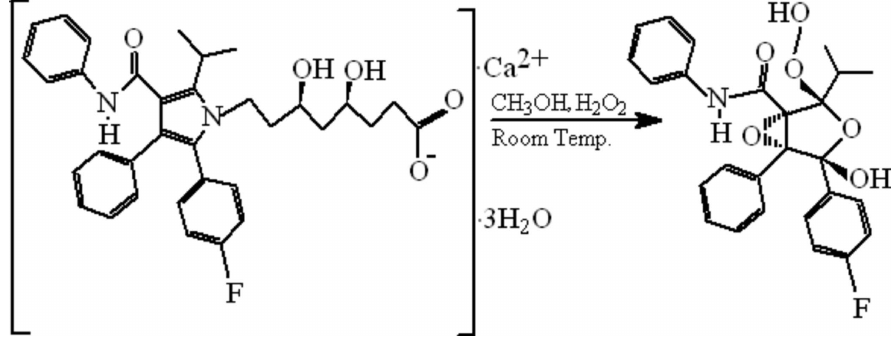
Figure 2 The formation of the title